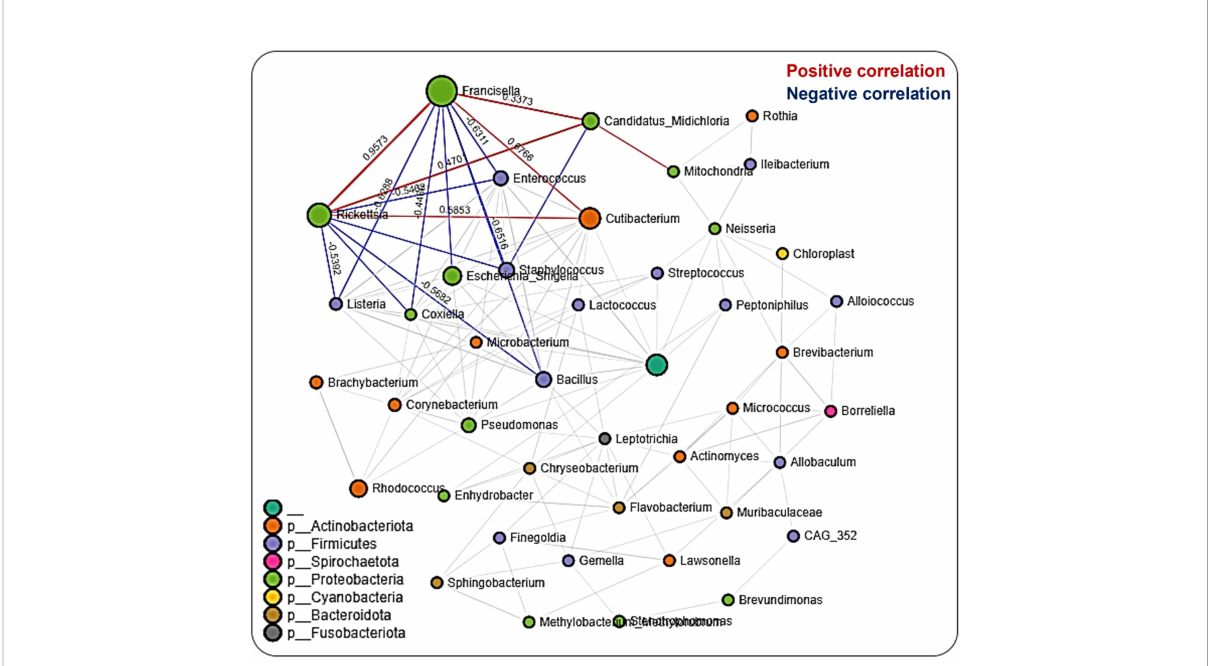
FIGURE 4 Correlation network analysis across the life stages of Am. maculatum ticks. Correlation network generated using the SparCC algorithm. Correlation network with nodes representing taxa at the family level and edges representing correlations between taxa pairs. Node size correlates with the number of interactions in which a taxon is involved, and the line color represents either positive (red) or negative (blue) correlations. The color-coded legend shows the bacterial family to which each taxon